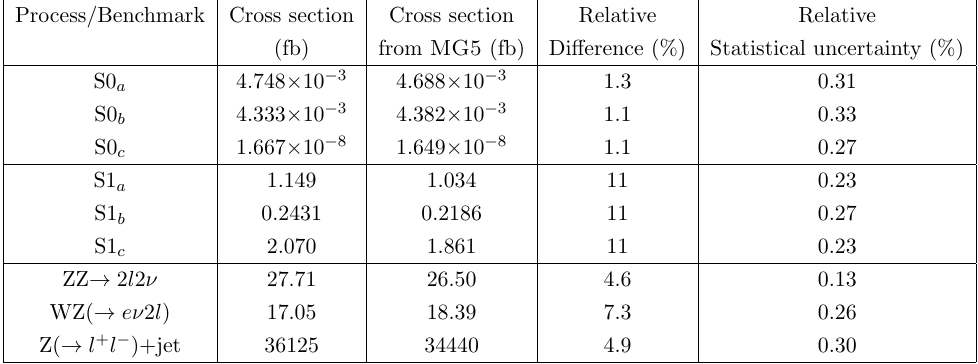
Table 8 . Comparison of cross sections obtained by our program and the MG5 , with Z boson leptonically decayed. Our program considered all the BL-selections with NWA, while the MG5 ones replace the NWA with m ll m Z < 15 (cid:0) Z . Hence the MG5 results are in general slightly j (cid:0) j (cid:2) smaller than ours. Their di(cid:11)erences and the statistical uncertainties taken from the MG5 are presented relative to the MG5